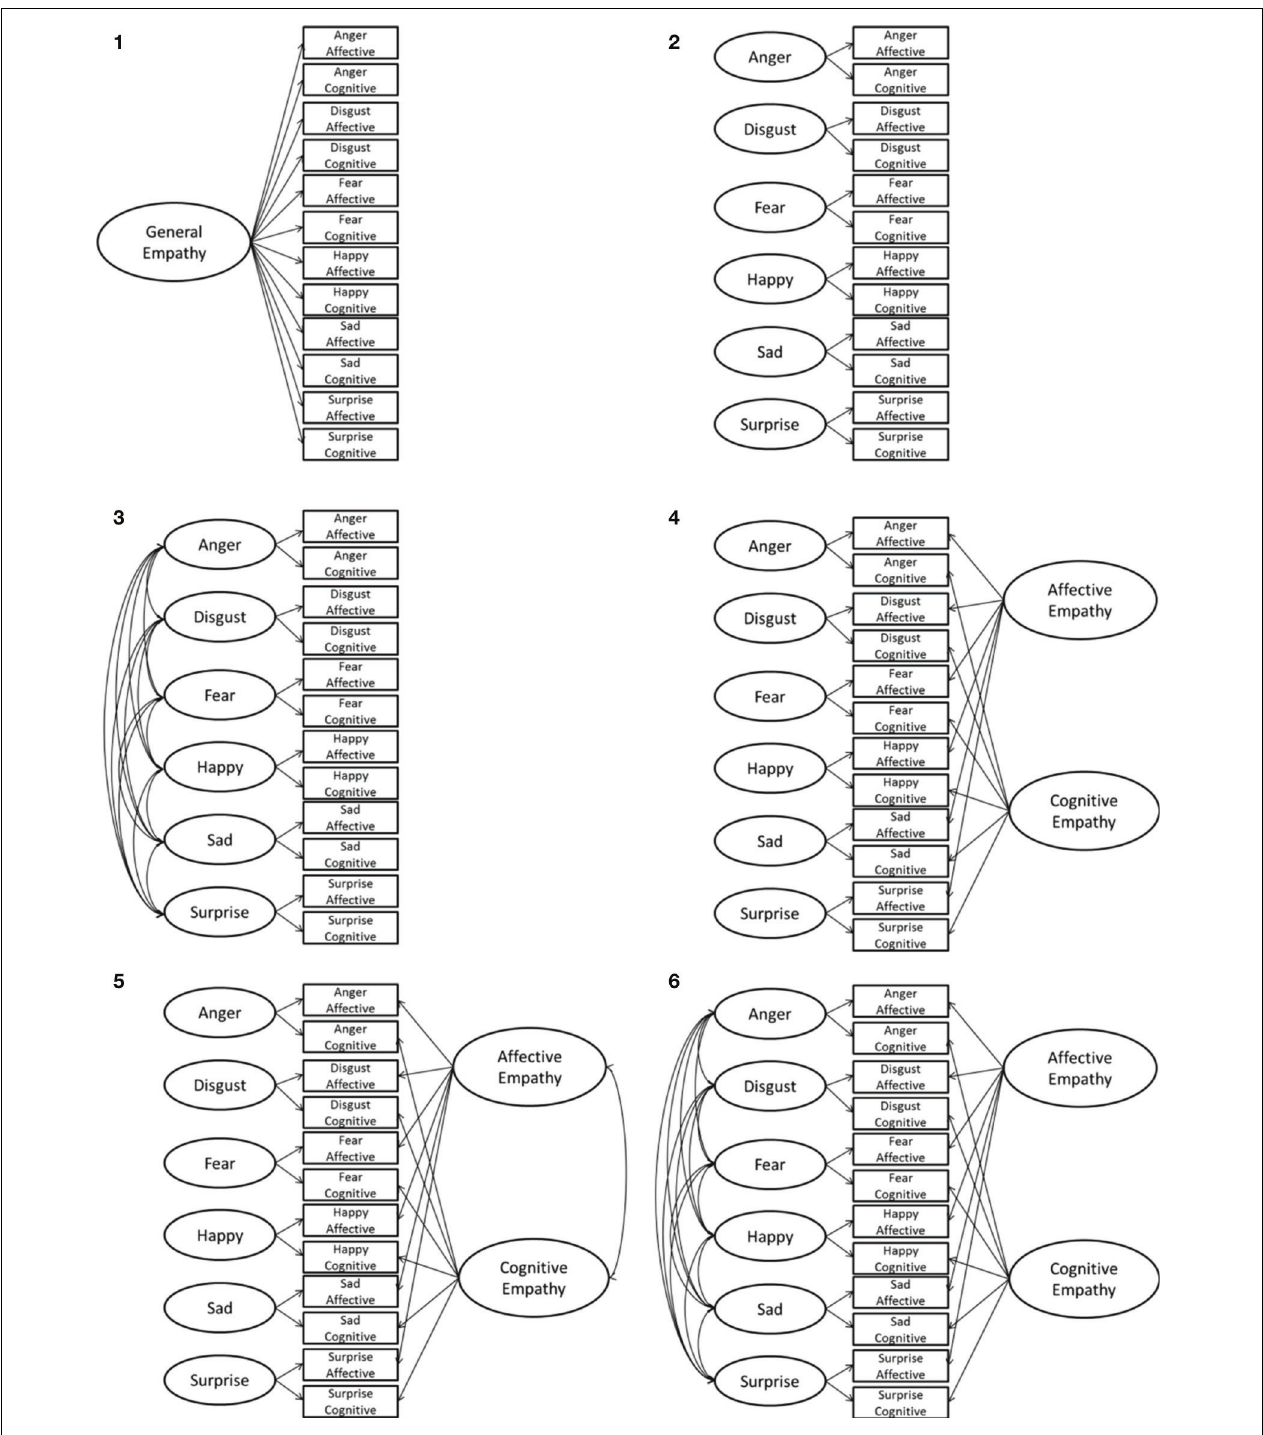
FIGURE 1 | Hypothesized Measurement Model Structures based on the MTMM framework.